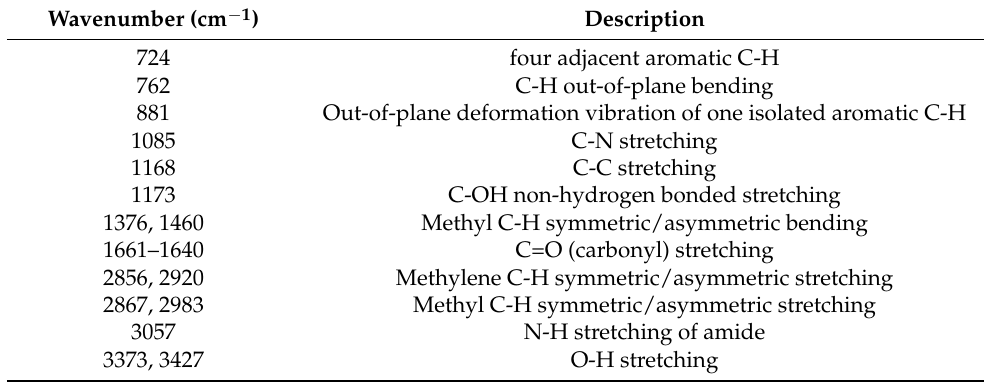
Table 3. Peak descriptions of the ATR-FTIR for the undoped and [EMIM]Cl-doped